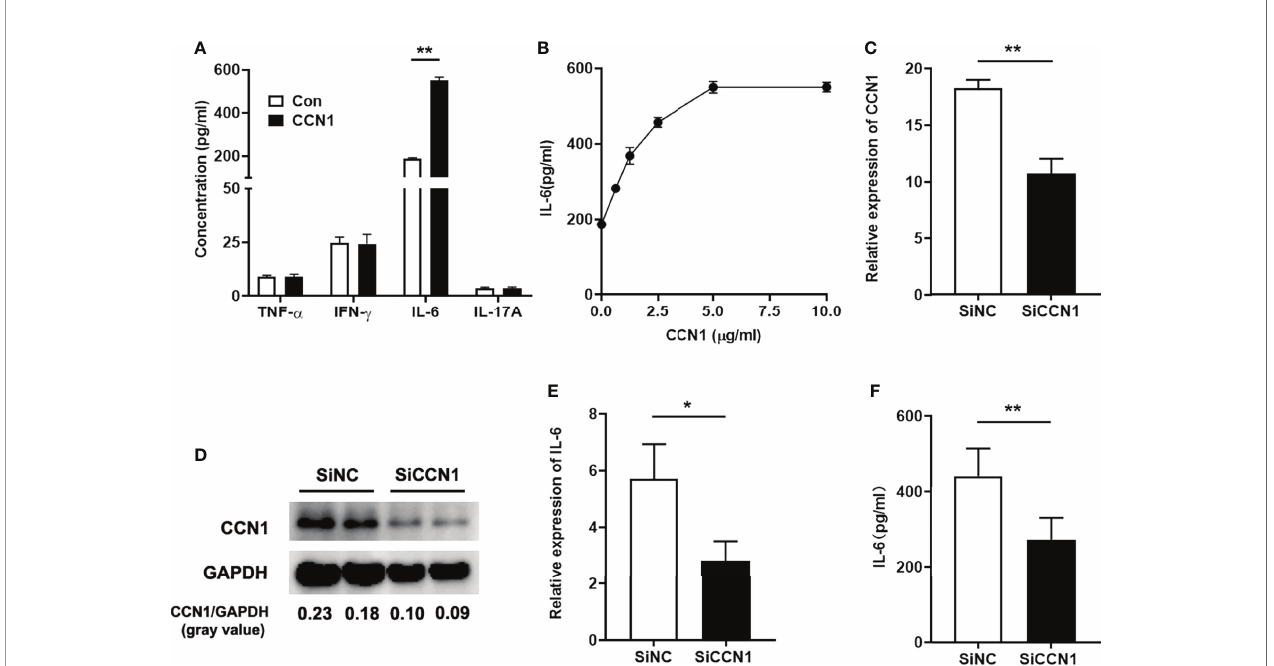
FIGURE 6 | CCN1 induced IL-6 production in LO2 cells. (A) IFN- g , IL-17, IL-6 and TNF- a concentration in supernatant of LO2 cells stimulated by CCN1 (5 m g/ml). (B) IL-6 concentration in supernatant of LO2 cells stimulated by CCN1 (2.5, 5, 7.5, 10 m g/ml). (C) CCN1 mRNA expression in CCN1-knockdown LO2 cells. (D) CCN1 protein expression in CCN1-knockdown LO2 cells. The relative expression of CCN1 protein was expressed by gray value. (E) IL-6 mRNA expression in LO2 cells treated with SiCCN1 (small interfering RNA against CCN1, black bar) or SiNC (small RNA of negative control, open bar). (F) IL-6 level in culture supernatant of LO2 cells treated with SiCCN1 or SiNC. *p<0.05, **p<0.01. All experiments were independently repeated at least three times in